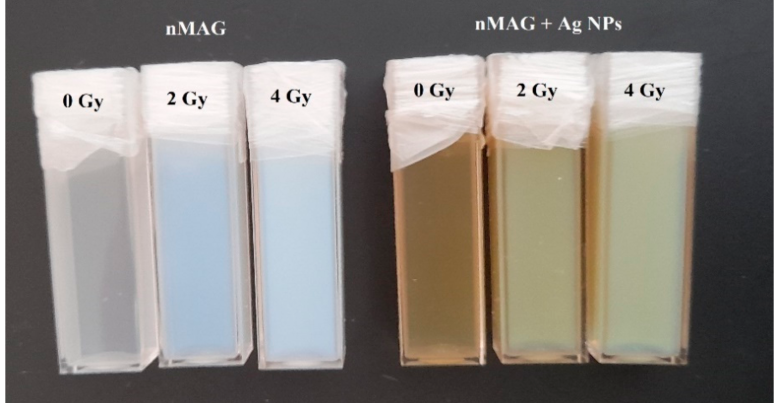
Figure 8. Original and modified with silver nanoparticles nMAG dose gels irradiated to differ- ent doses.